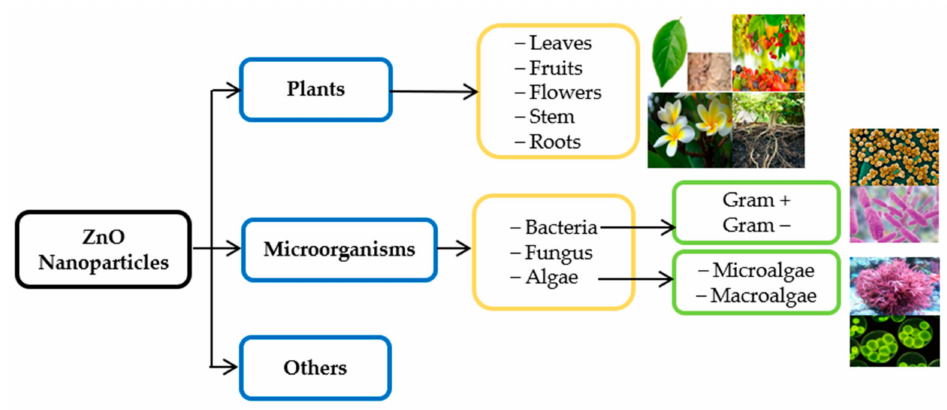
Figure 12. Synthesis of ZnO NPs by using various biological species. Elaboration from Ref. [156].